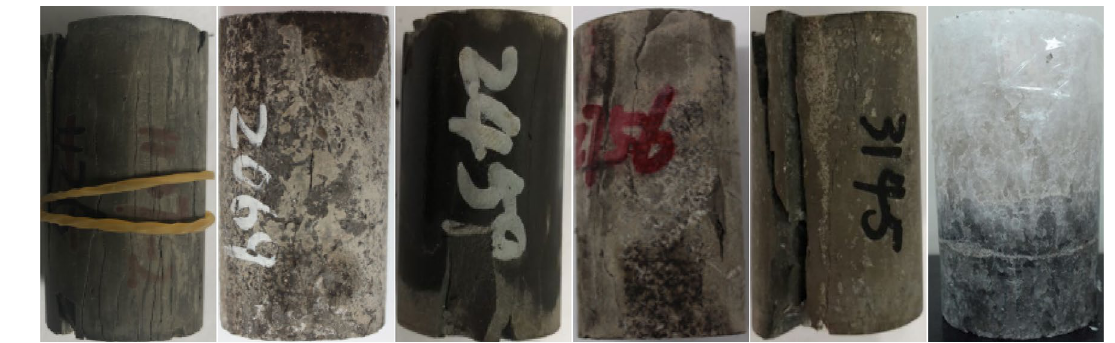
Fig. 4 Fracture characteristics of specimens under uniaxial compression